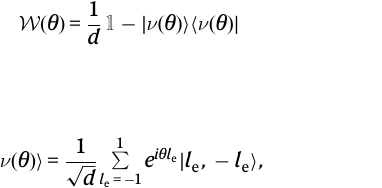
contribution is computed by taking the peak value of the momentum dependent probability of each channel individually. The values are normalized by the largest channel and in arbitrary units. We show E N , h W ð 0 Þi , h W ð π Þi and the phase Þ , see (8).The excited state labels, atthe top andbottom of the panels, θ α = arg ð α 10 i , where n is the principle quantum number, ℓ is the are in the format ∣ η i = ∣ n ‘ m η angular quantum number and m η is the magnetic quantum